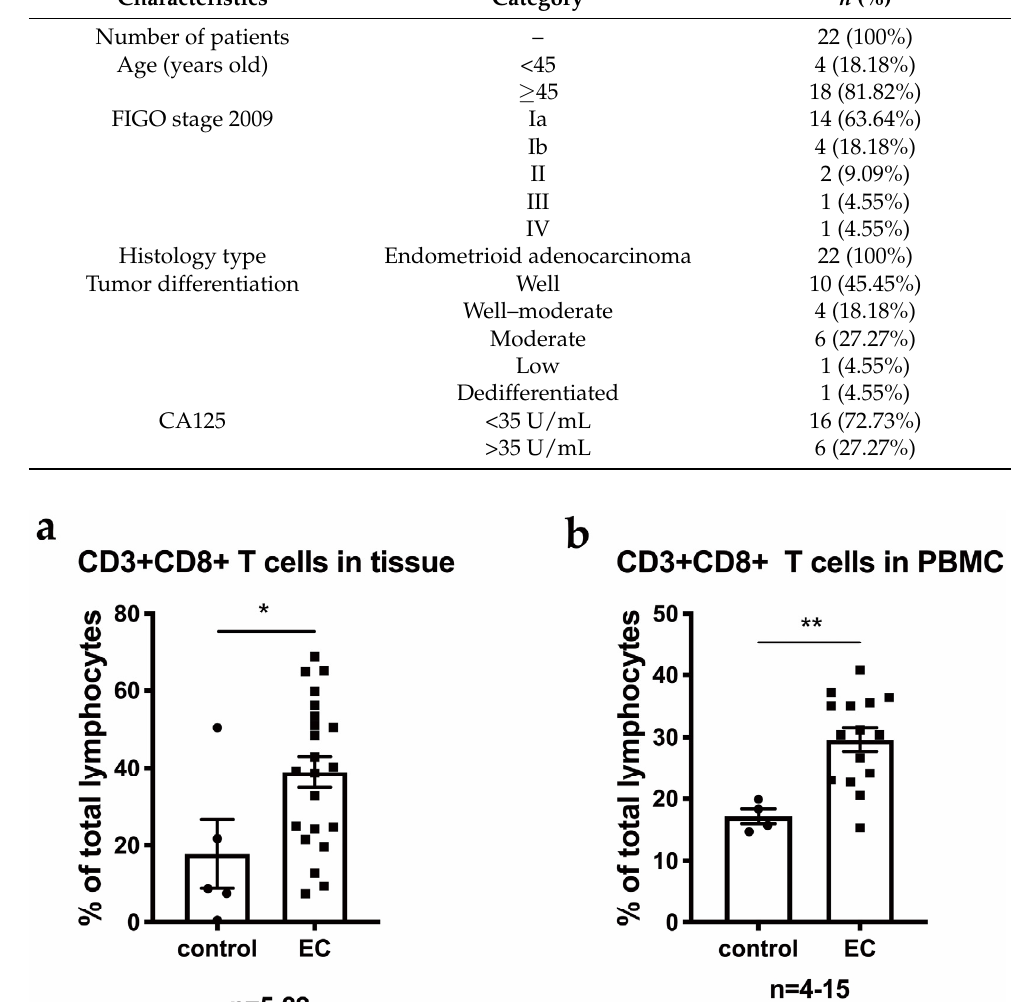
Figure 1. CD8 T cells are enriched in TILs from EC. ( a ) The percentages of CD8 T cells among all lymphocytes in EC tissue, prolapsed uterus (control) and ( b ) PBMCs from the corresponding patients. p value compares the indicated group using an unpaired t -test (two-tailed). p < 0.05 (*), p < 0.01 (**). Table 1. Characteristics of the patients enrolled for flow cytometry.